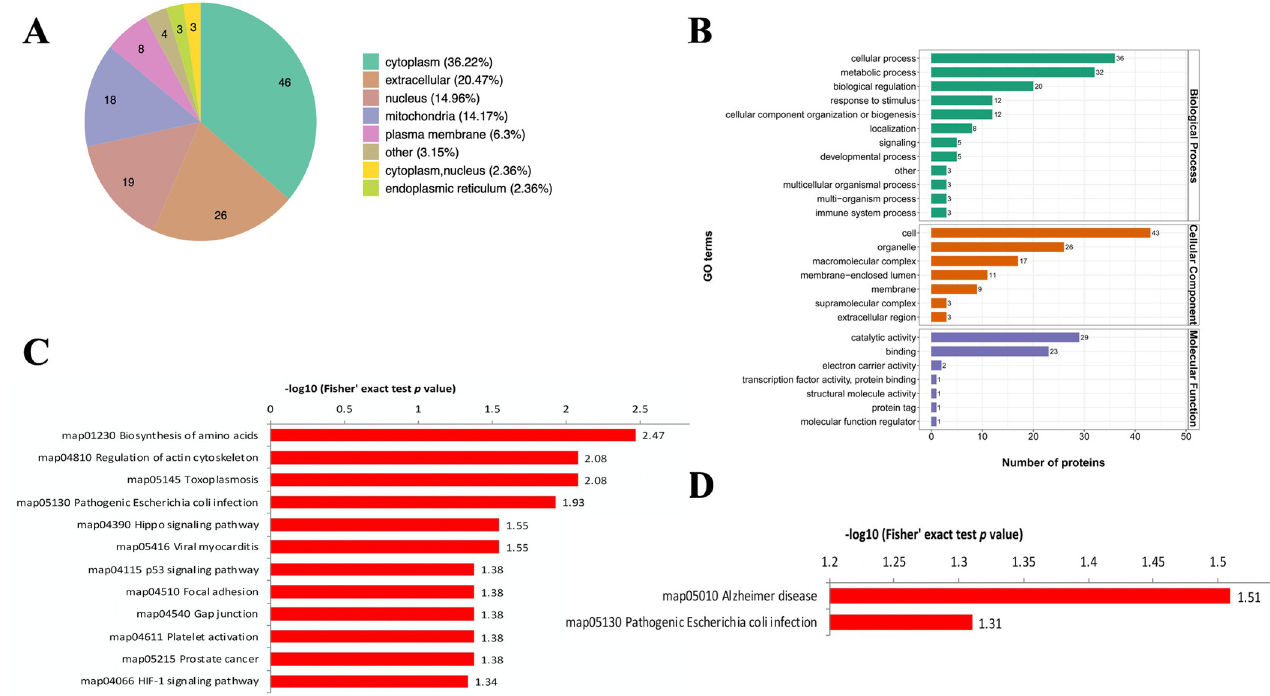
Fig 3. Functional enrichment analysis of the differentially malonylated proteins in RH vs. PRU strains. (A) Subcellular location of differentially lysine malonylated proteins in T . gondii . (B) Primary GO enrichment analysis of the differentially malonylated proteins. (C) KEGG pathway enrichment of differentially malonylated proteins. (D) KEGG pathway enrichment of the downregulated malonylated proteins.